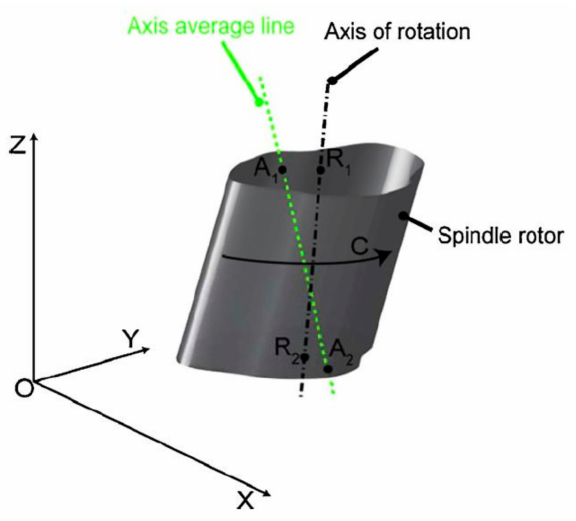
Figure 49. The concept of the axis of rotation and axis average line (AVL) [39].